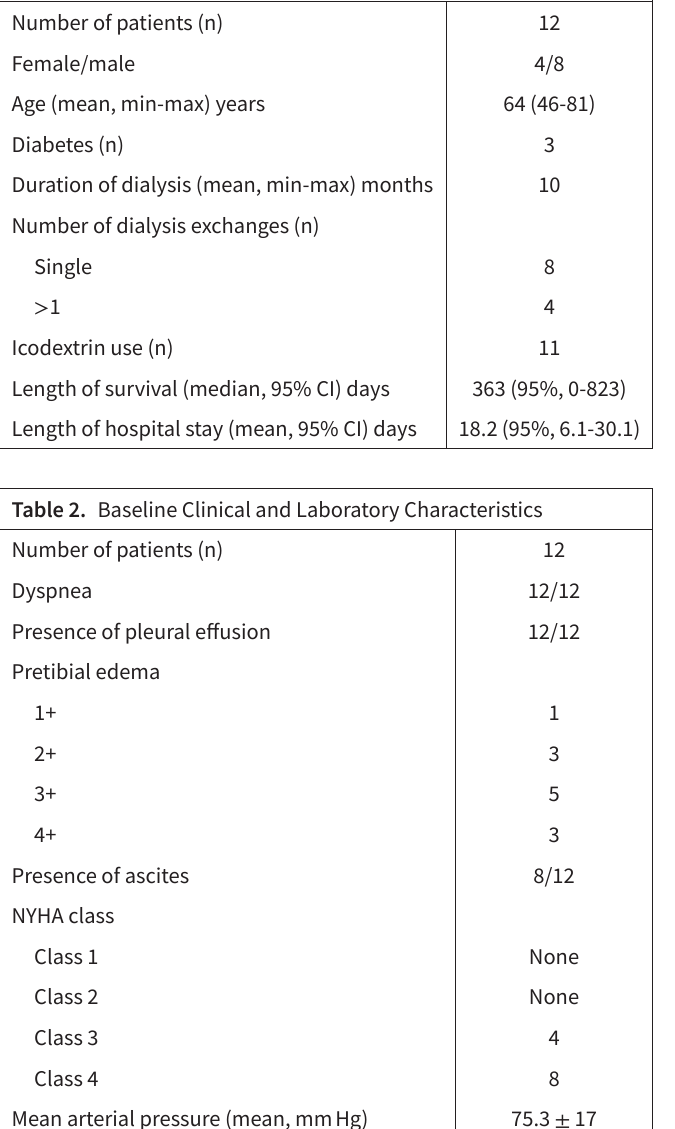
Table 1. Demographic Characteristics